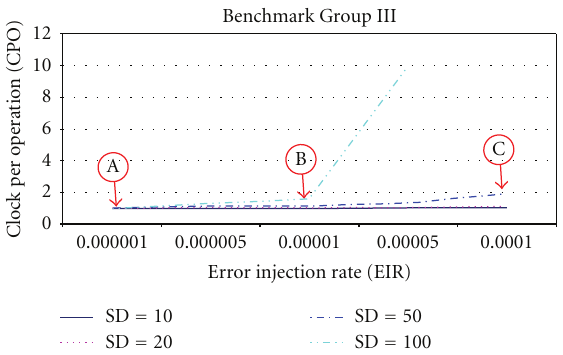
Figure 27: Simulation Curves for Group III.